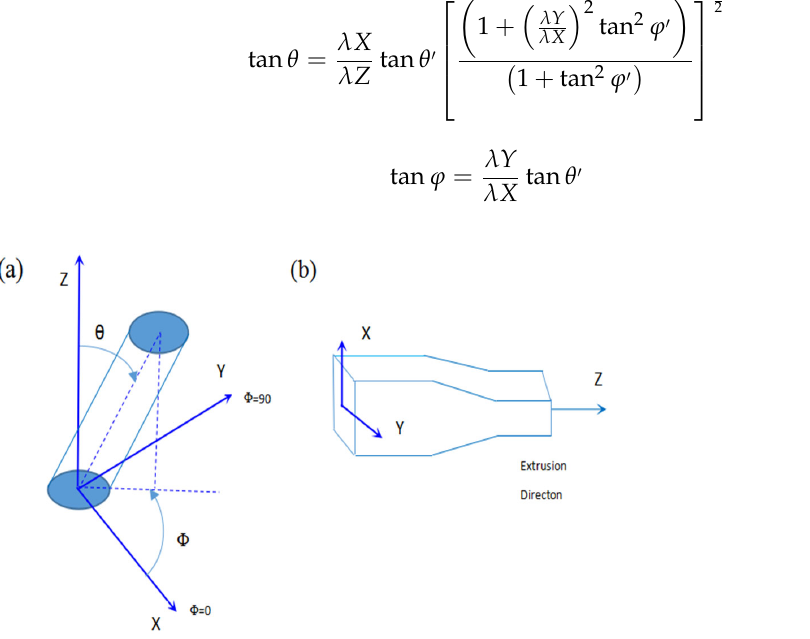
Figure 4. ( a ) Schematics of the TiB fibers’ orientation in the composite. ( b ) Changes in the TiB fibers’ orientation during thermal deformation.